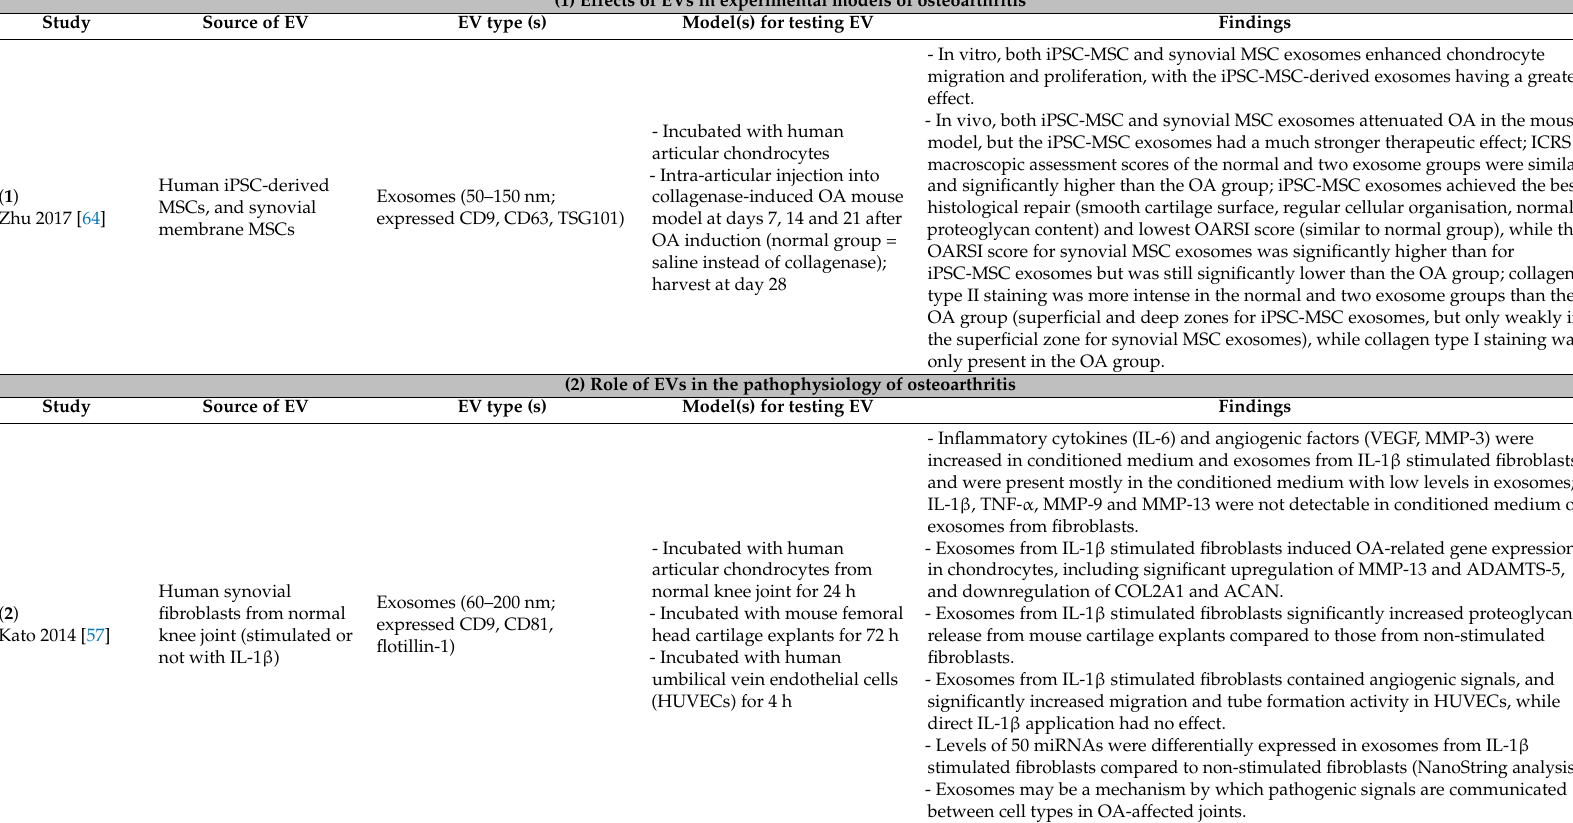
(1) Effects of EVs in experimental models of osteoarthritis